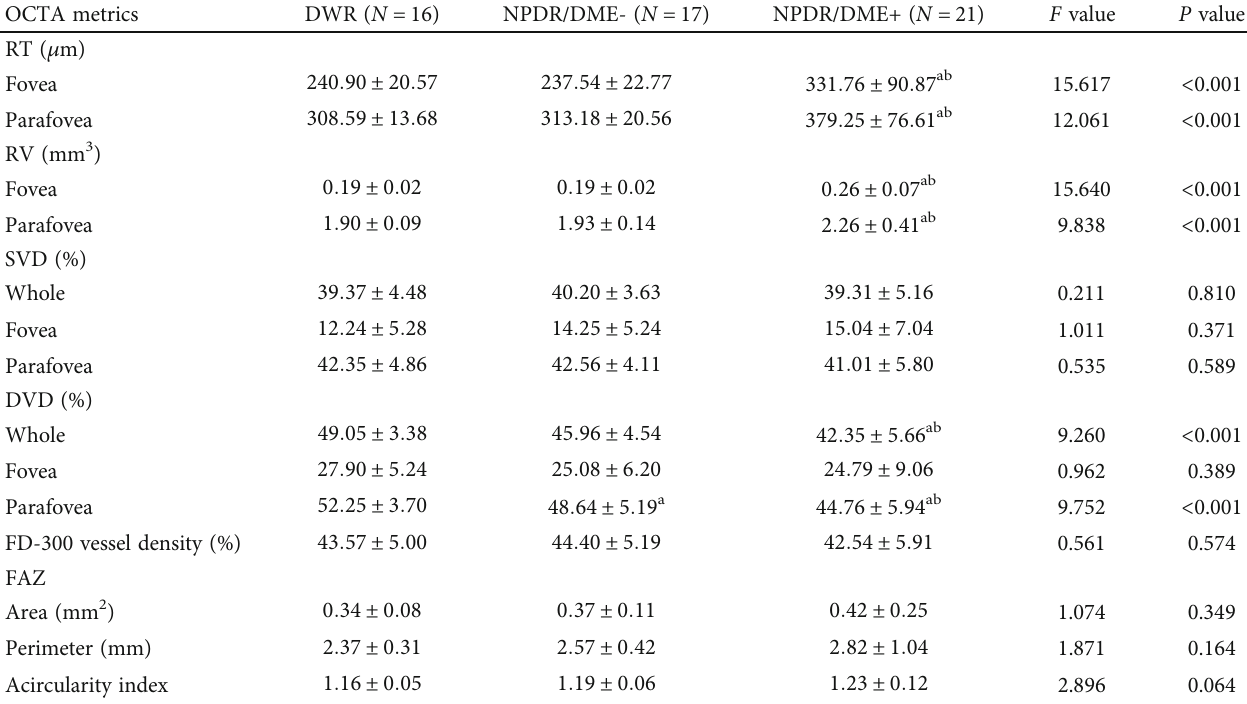
Table 3: Comparison of the OCTA Metrics among the 3 groups ( mean ± SD ).